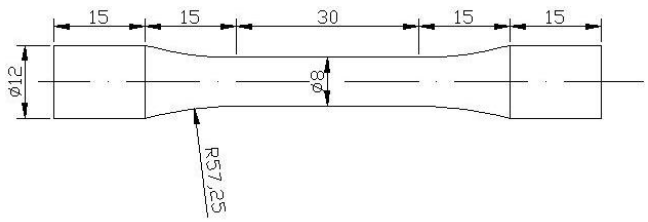
Figure 2. Shape and dimension specimens of low cycle fatigue.